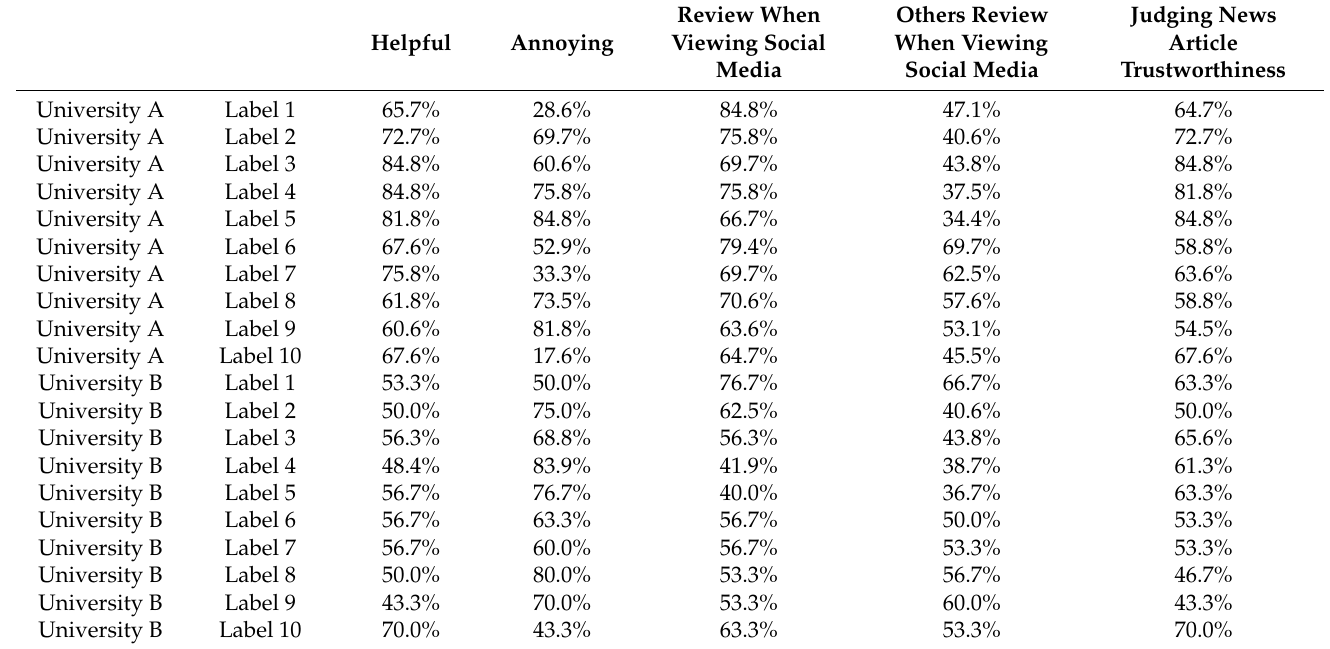
Table 8. Results of survey 2 by label and by school.